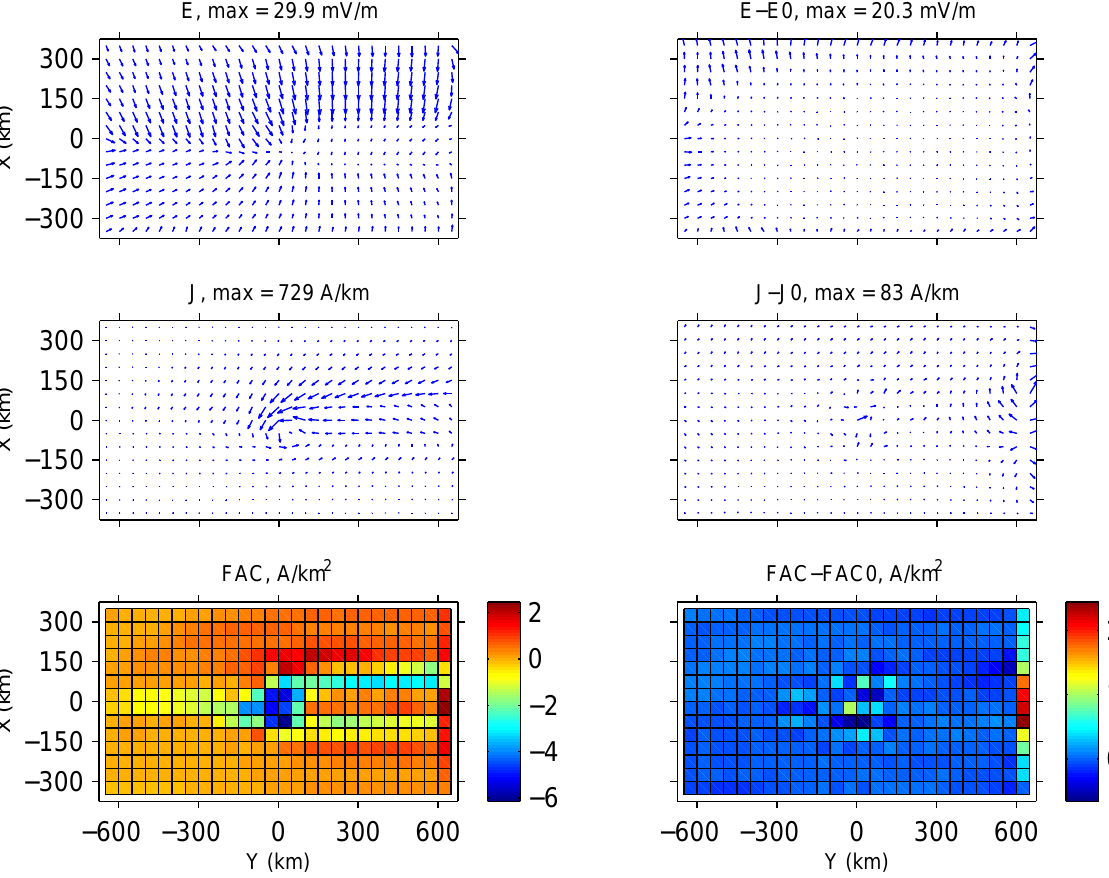
Fig. 5. Example where the elementary system -based local KRM method is applied to an empirical model of a westward traveling surge. Lefthand panels show the electric field, horizontal current and FAC obtained with the SECS-based KRM method, while the righthand panels show the difference between the solution and the original model. Adapted from Fig. 10 of Vanham¨aki and Amm